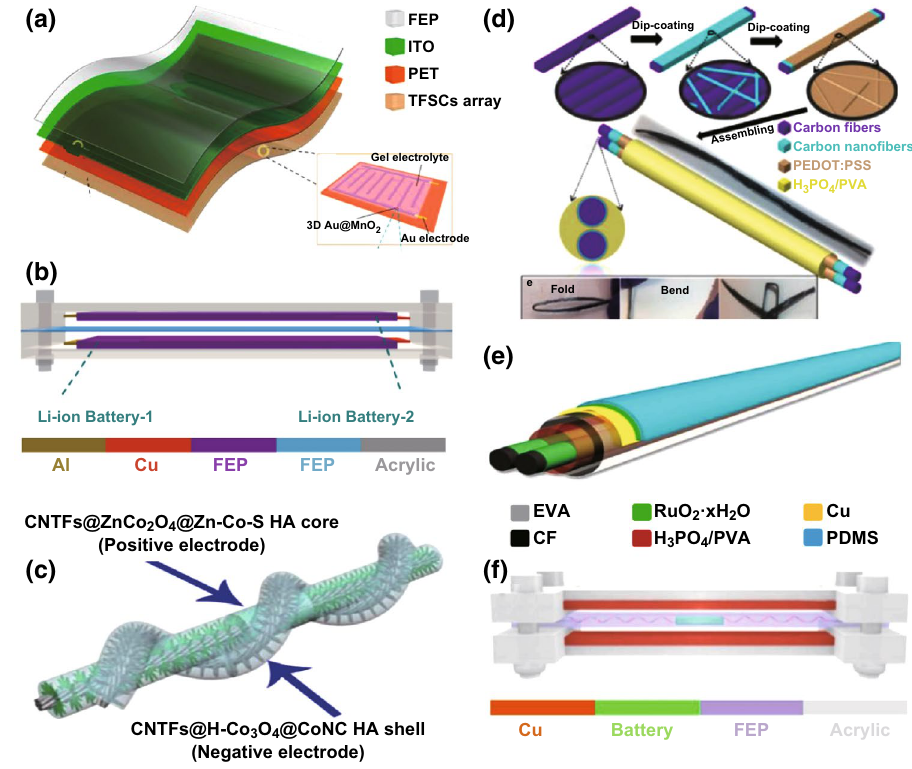
Fig. 5 Schematic illustration of a the transparent and flexible SCPF. Reprinted with permission from Ref. [18]. b Self‑charging Li‑ion batteries. Reprinted with permission from Ref. [19]. c the assembled structure of the FASC. Reprinted with permission from Ref. [20]. d Fabrication pro‑ cess of the all‑solid‑state symmetric yarn SC composed of two PEDOT:PSS/CNF/CF electrodes in parallel. Reprinted with permission from Ref. [22]. Schematic diagram of e a single F‑SC, consisting of two carbon fibers coated with RuO 2 ·xH 2 O in the H 3 PO 4 /PVA electrolyte. Reprinted with permission from Ref. [23]. f the fabricated device. Reprinted with permission from Ref.